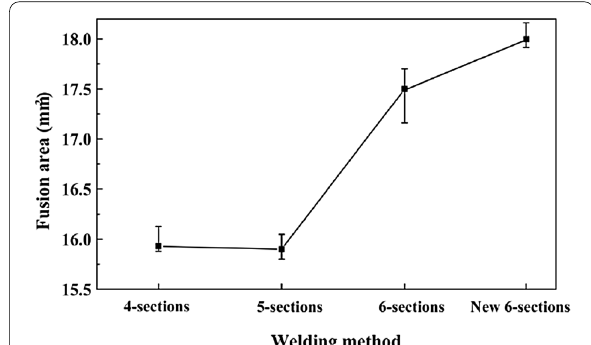
Figure 25 Fusion area of the combined surface of the welded joint under different welding methods